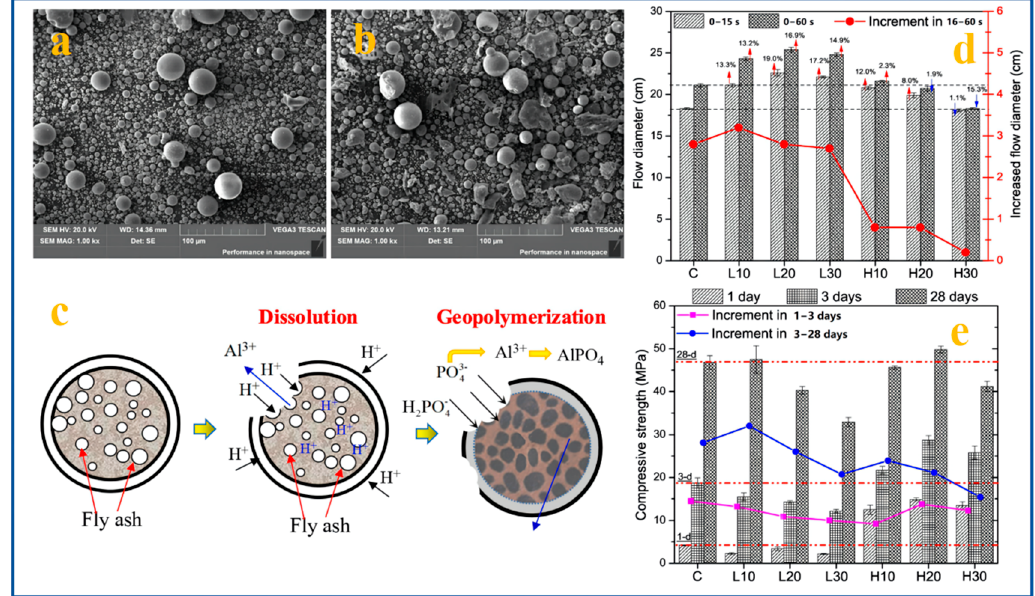
Figure 3. ( a ) SEM image of LCFA, ( b ) SEM image of HCFA, ( c ) geopolymerization mechanism for FA-ASP geopolymers, ( d ) fluidity of the ASP geopolymers with different types and contents of FA, and ( e ) compressive strength results of the FA-ASP geopolymers with different types and contents of FA [33,35].